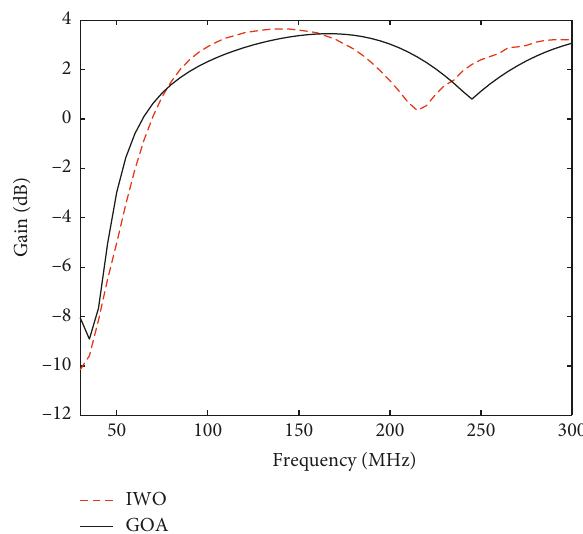
Figure 19: The gain of 10:1 scaled optimized whip